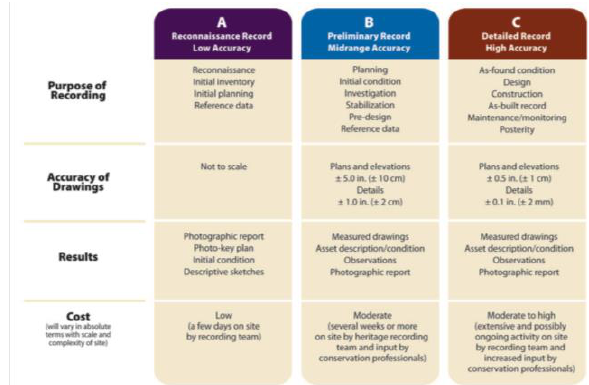
Figure 4. Levels of documentation A-rapid, B-detailed and C-